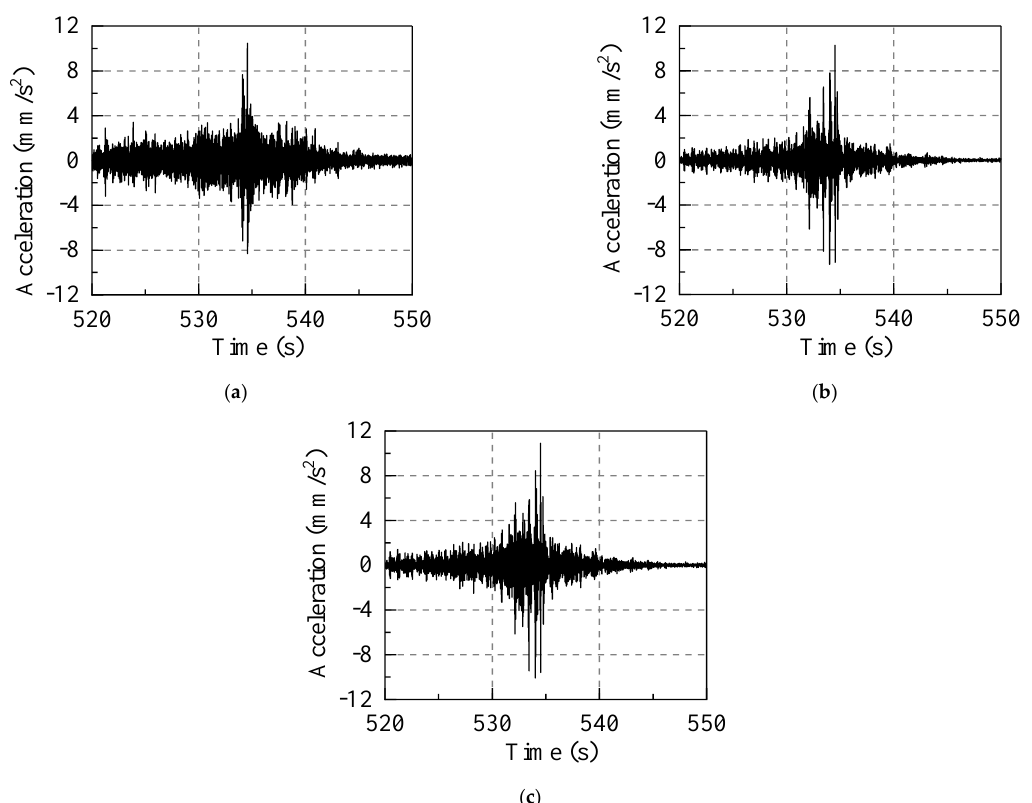
Figure 17. Acceleration time − history of the third floor measuring point (D − P2): ( a ) traffic − induced acceleration in third floor measuring point (D − P2); ( b ) third floor measuring point (D − P2) acceleration time − history prediction based on the amplitude − RTR, and ( c ) third floor measuring point (D − P2) acceleration time − history prediction based on the RMS − RTR.